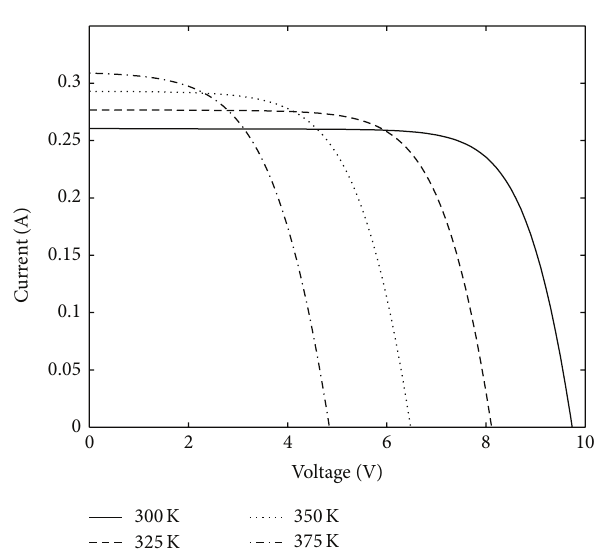
Figure 10: Variation of current-voltage characteristics with the cell temperature 𝑇 𝐶